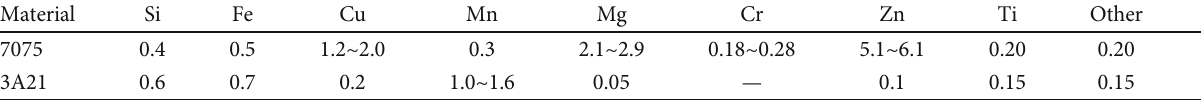
Table 1: Chemical composition of the 7075 and the 3A21 (mass fraction, %).